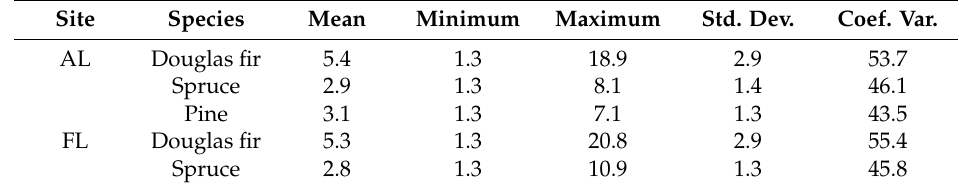
Table 5. Impact bending strength (in J · cm − 2 ) of individual tree species according to the evaluated site.